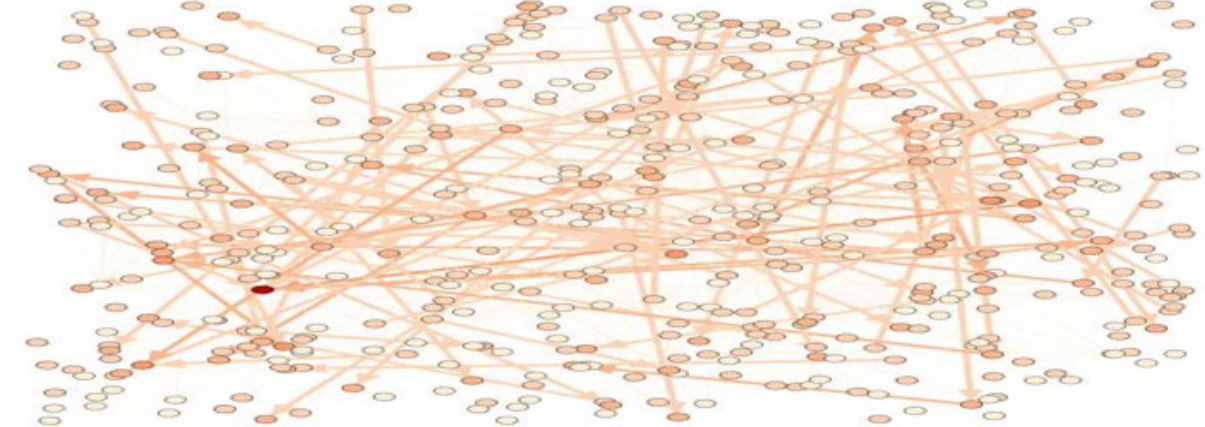
Figure 10. Graphs of messages without categories according to their repercussion